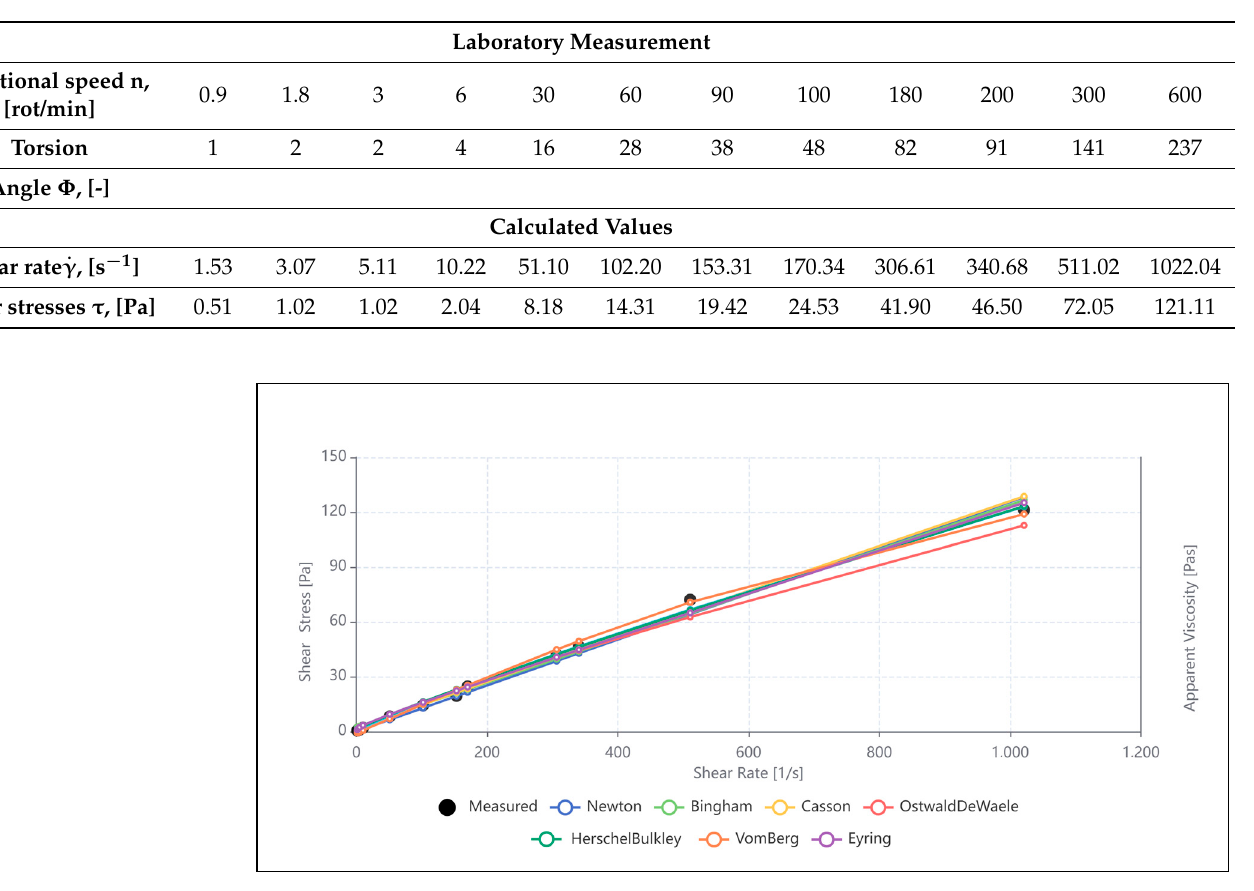
Figure 7. Graphical comparison of rheological models’ fitness to the measurement. Table 2. Tabular comparison of rheological models’ fitness to the measurement.